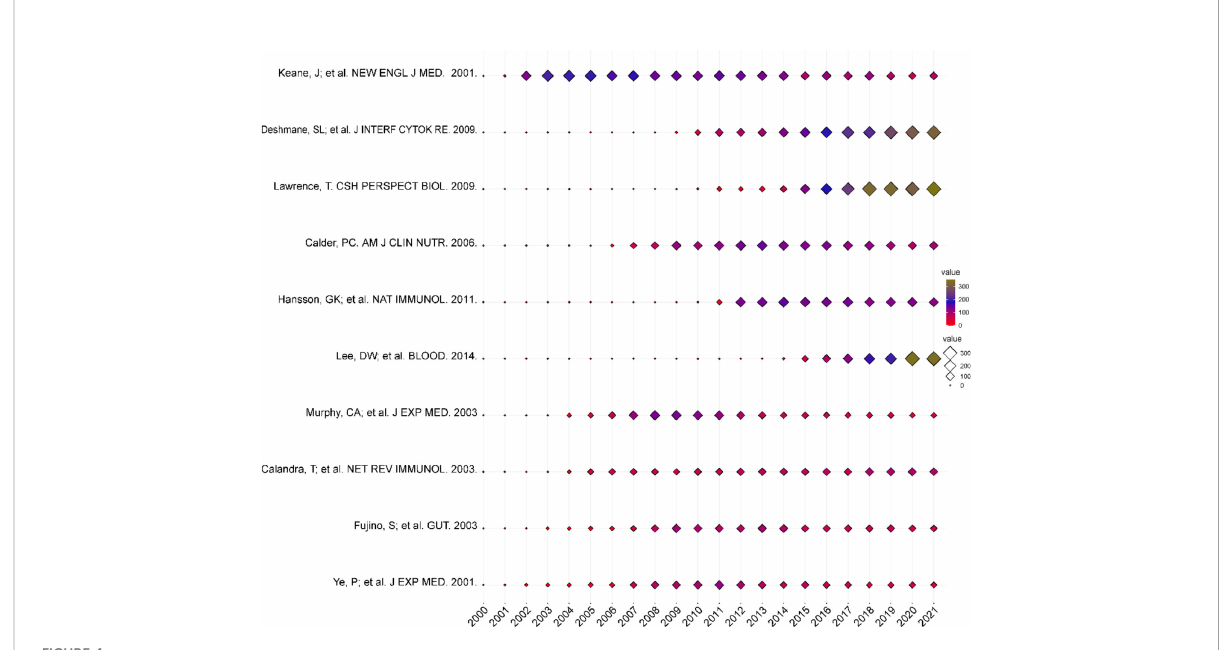
FIGURE 4 The yearly number of citations of papers with high